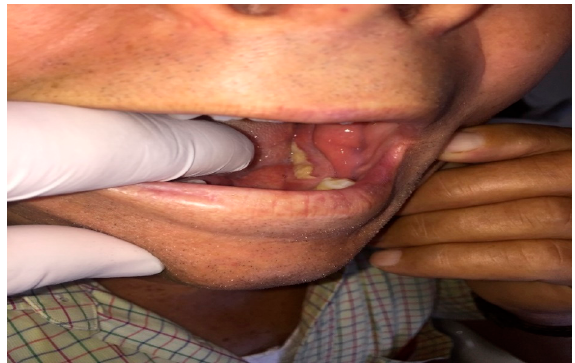
Figure 5. First visit to patient with odontogenic abscess left mandibular angle.